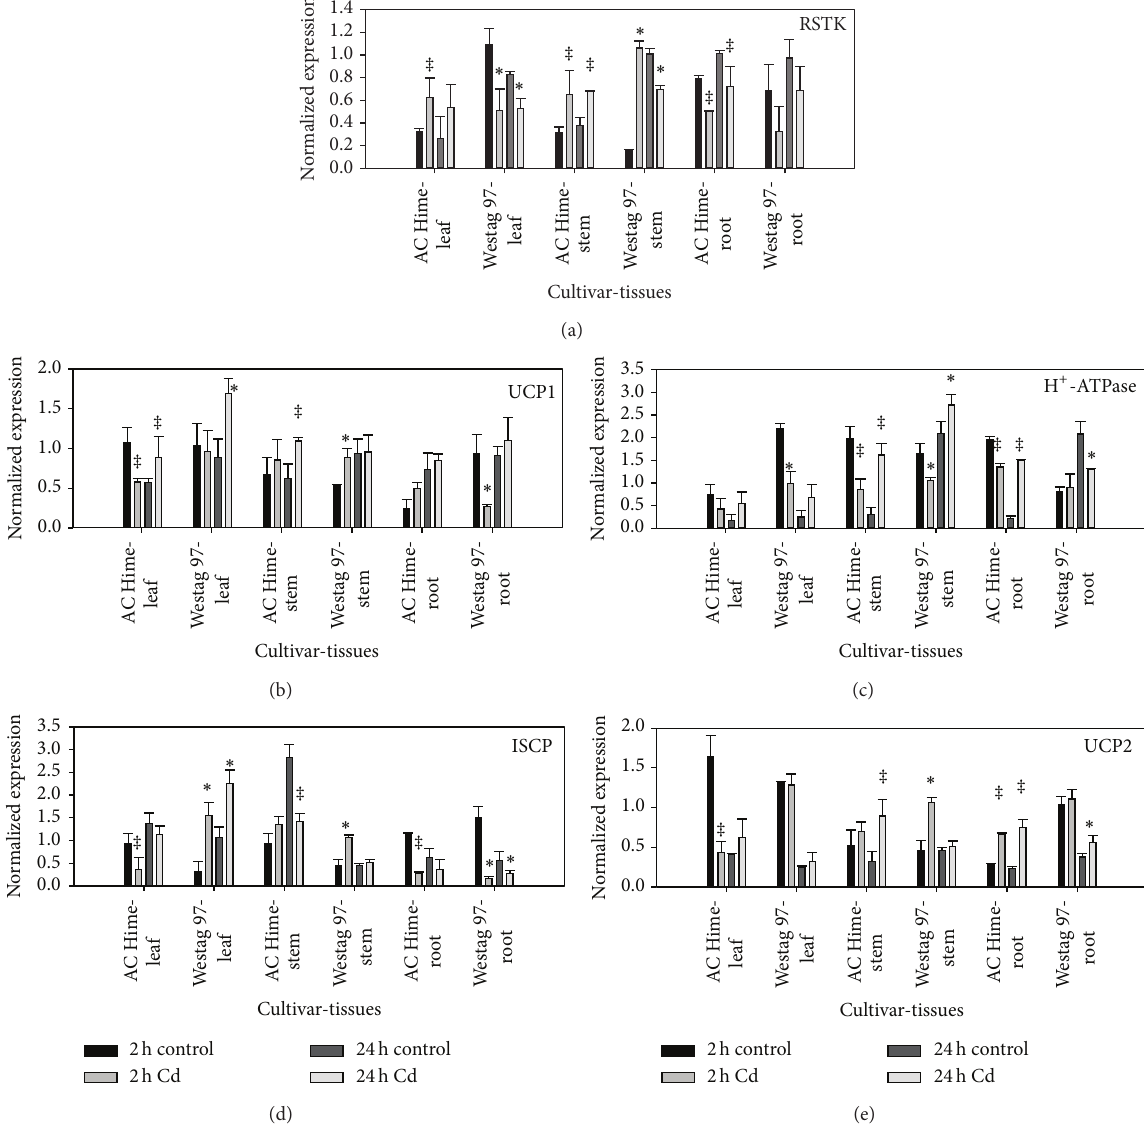
Figure 2: The expression pattern of RSTK, H + -ATPase, ISCP, UCP1, and UCP2 in tissues of AC Hime and Westag 97 exposed to different Cd concentrations at different times. Control: 0 𝜇 M Cd, High: 1.6 𝜇 M Cd, two sampling times at the 2 and 22 h. Each data point is the mean of the two biological replicates with three technical replicates. The bar represents the standard error ( 𝑛 = 3 ). The value that is statistically different at 𝑃 < 0.05 is indicated by ‡ (AC Hime) and ∗ (Westag 97), respectively.